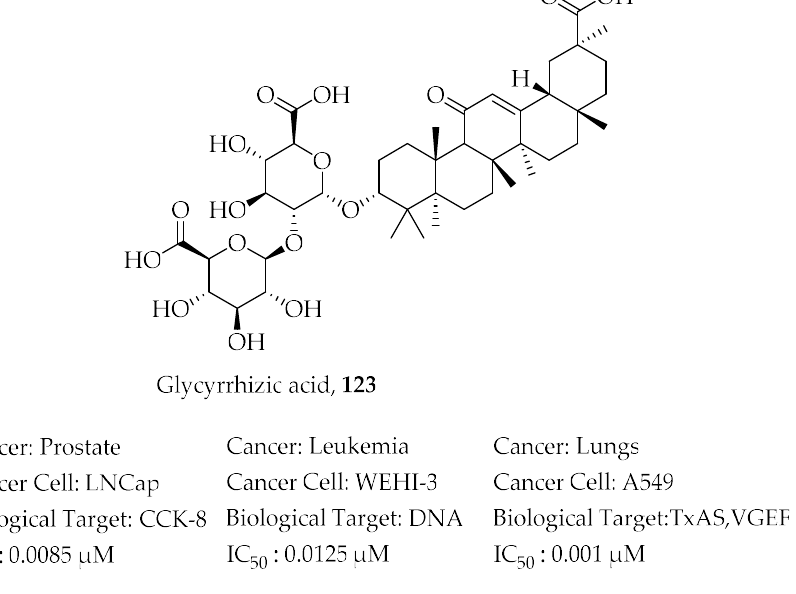
Figure 19. Structure of the triterpenoid glycoside Glycyrrhizic acid with a summary of its biological activity towards selected cancer targets.